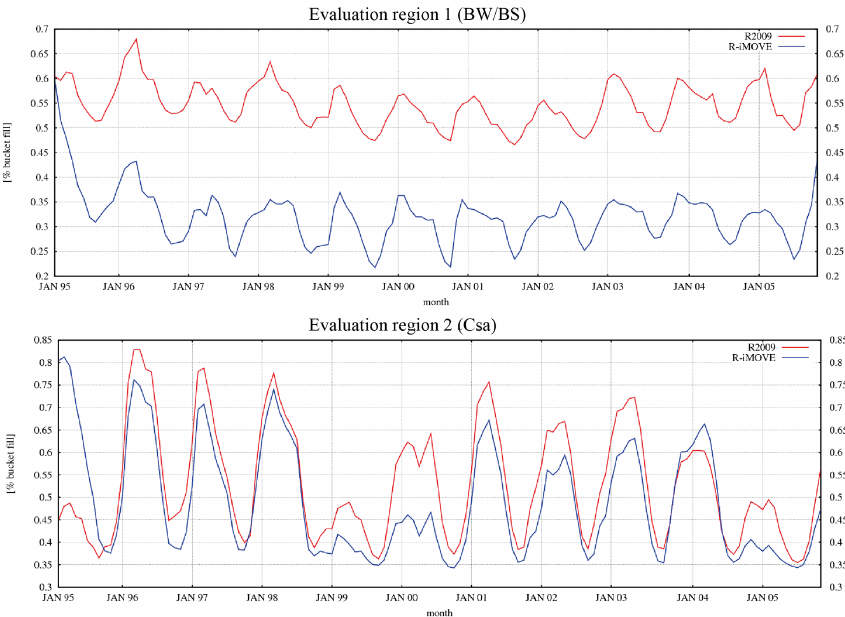
Figure 14. Annual courses of soil moisture in two evaluation regions of REMO-iMOVE and REMO2009 (compare Fig.